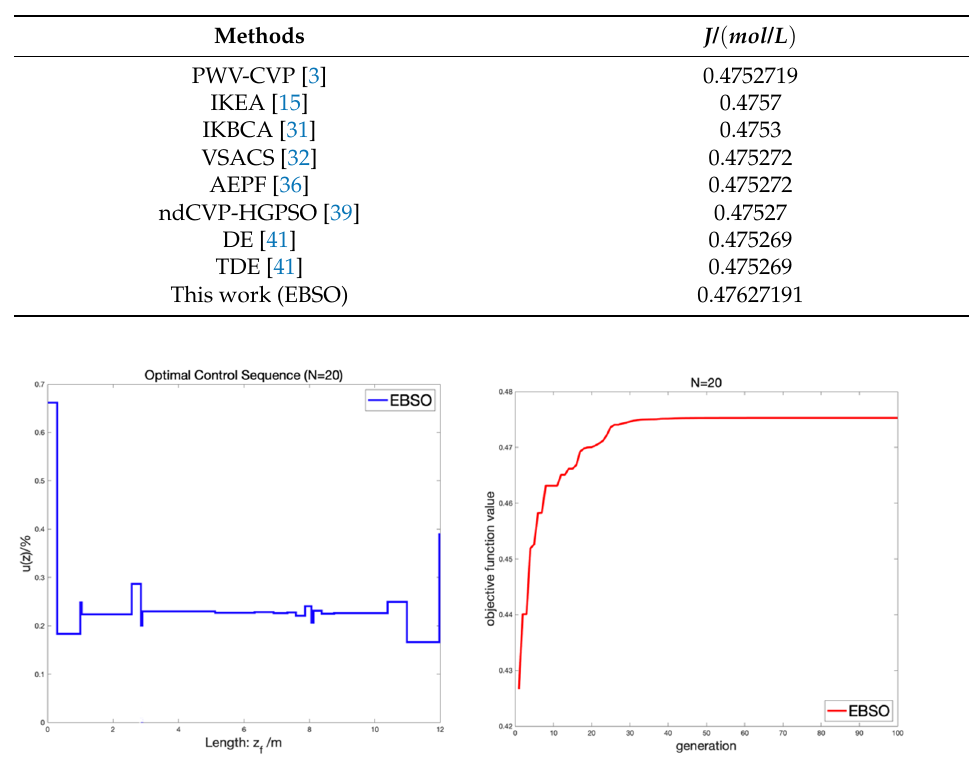
Figure 30. Optimal control trajectory and iteration curve ( 20 N = ).